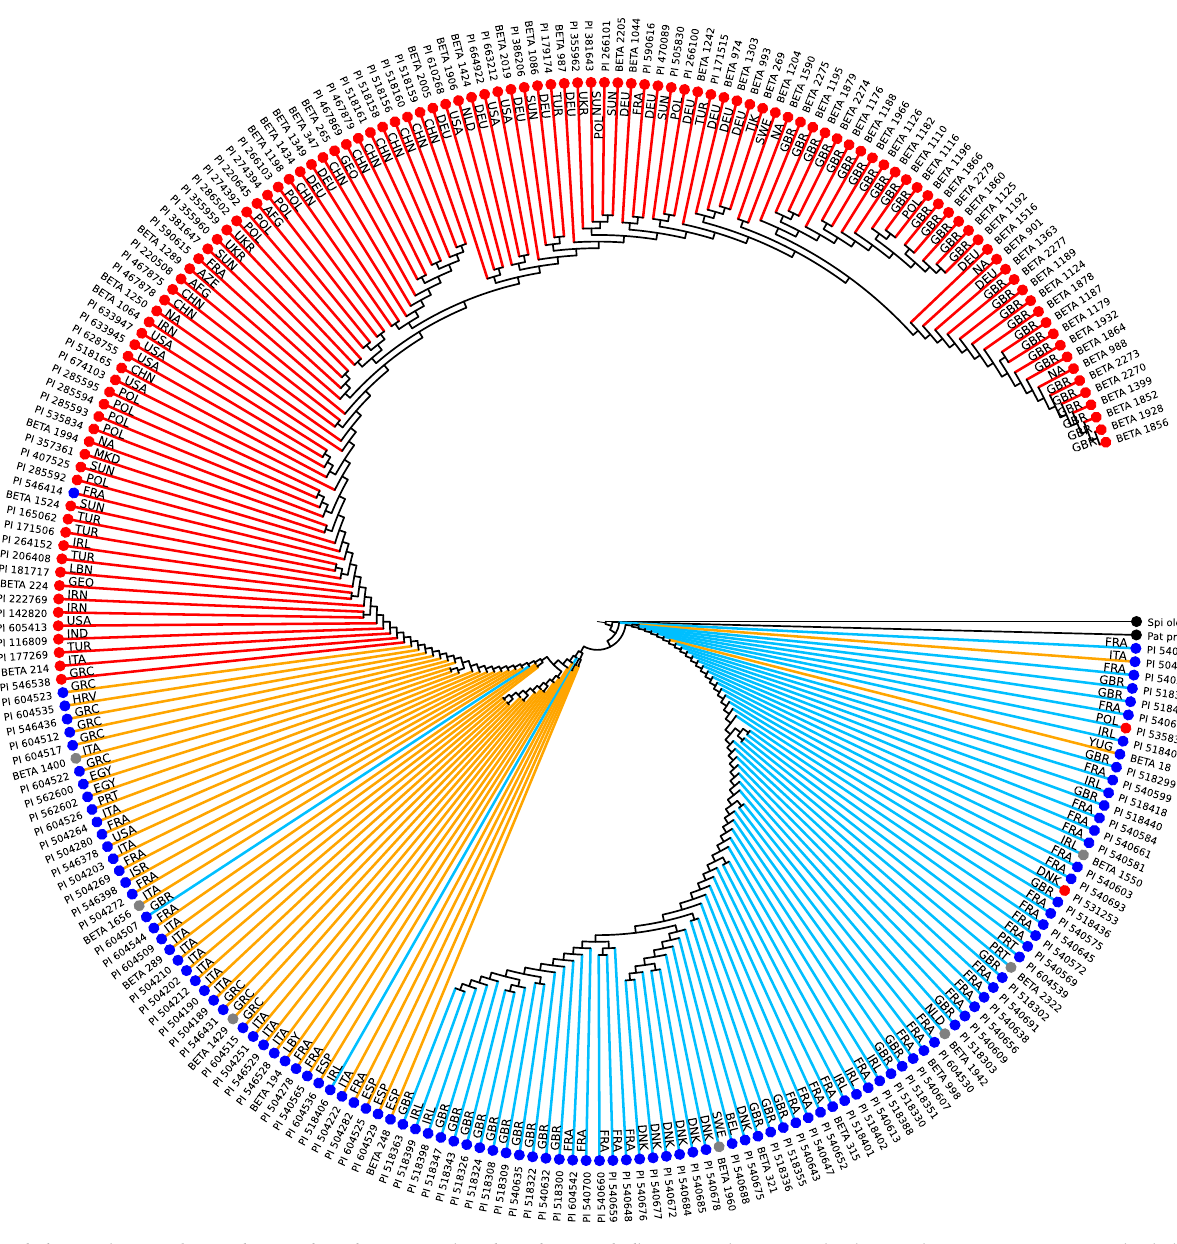
Fig. 3 Phylogenetic tree of sugar beet and sea beet accessions based on Mash distances. The 457 randomly sorted input accessions were divided in two subsets one of which is shown in this fi gure, the other one in Supplementary Fig. 2. For comparability, 19 randomly selected accessions as well as the two outgroups spinach (Spi olera) and Patellifolia procumbens (Pat pro) are present in both trees. Tree calculation was performed with the Fitch algorithm based on pairwise Mash distances. Leaf colors indicate taxonomic information prior to tree calculation (red: B. v. vulgaris , blue: B. v. maritima , gray: unknown subspecies, black: outgroup). Branch colors indicate B. v. vulgaris (red), sea beets from the Mediterranean area (yellow), and sea beets from Atlantic coasts (blue). Country codes were added according to information in public databases from USDA or IPK. Source data are provided as a Source Data fi